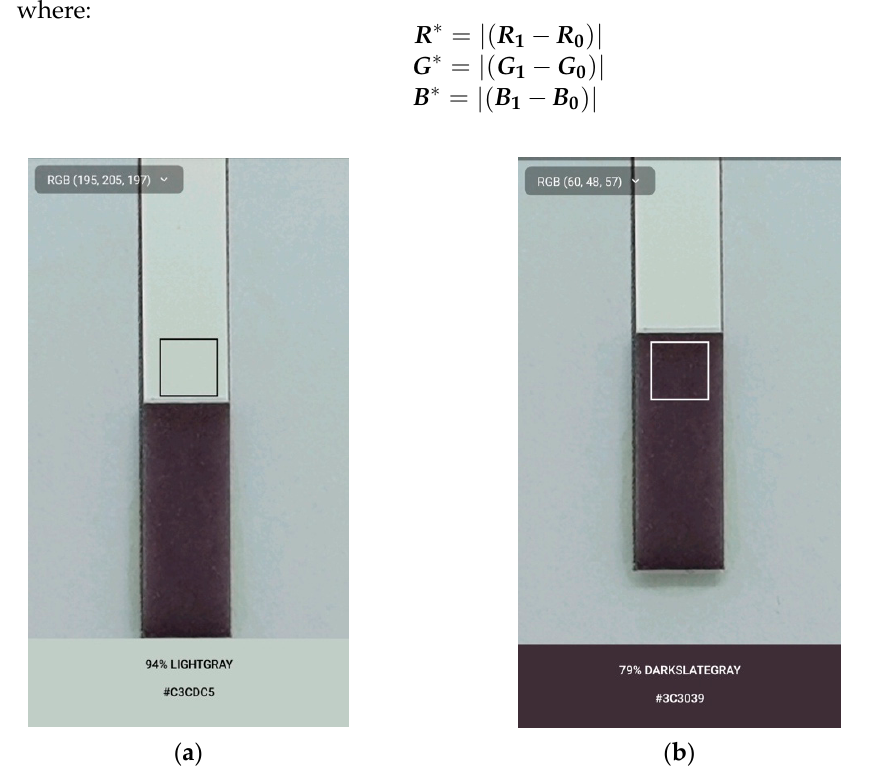
Figure 4. Colorimetric detection of the MTT-PMS strips following submersion into solution using the smartphone application ColorPicker: ( a ) RGB data collection of the white ribbon strips for standardization (R 0 , G 0 , B 0 ); ( b ) RGB data collection of the MTT cotton strips (R 1 , G 1 , B 1 ).